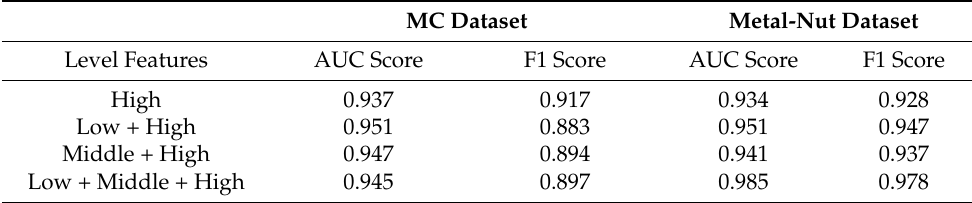
Table 5. Comparison results between different features-level selection for MiLF module.